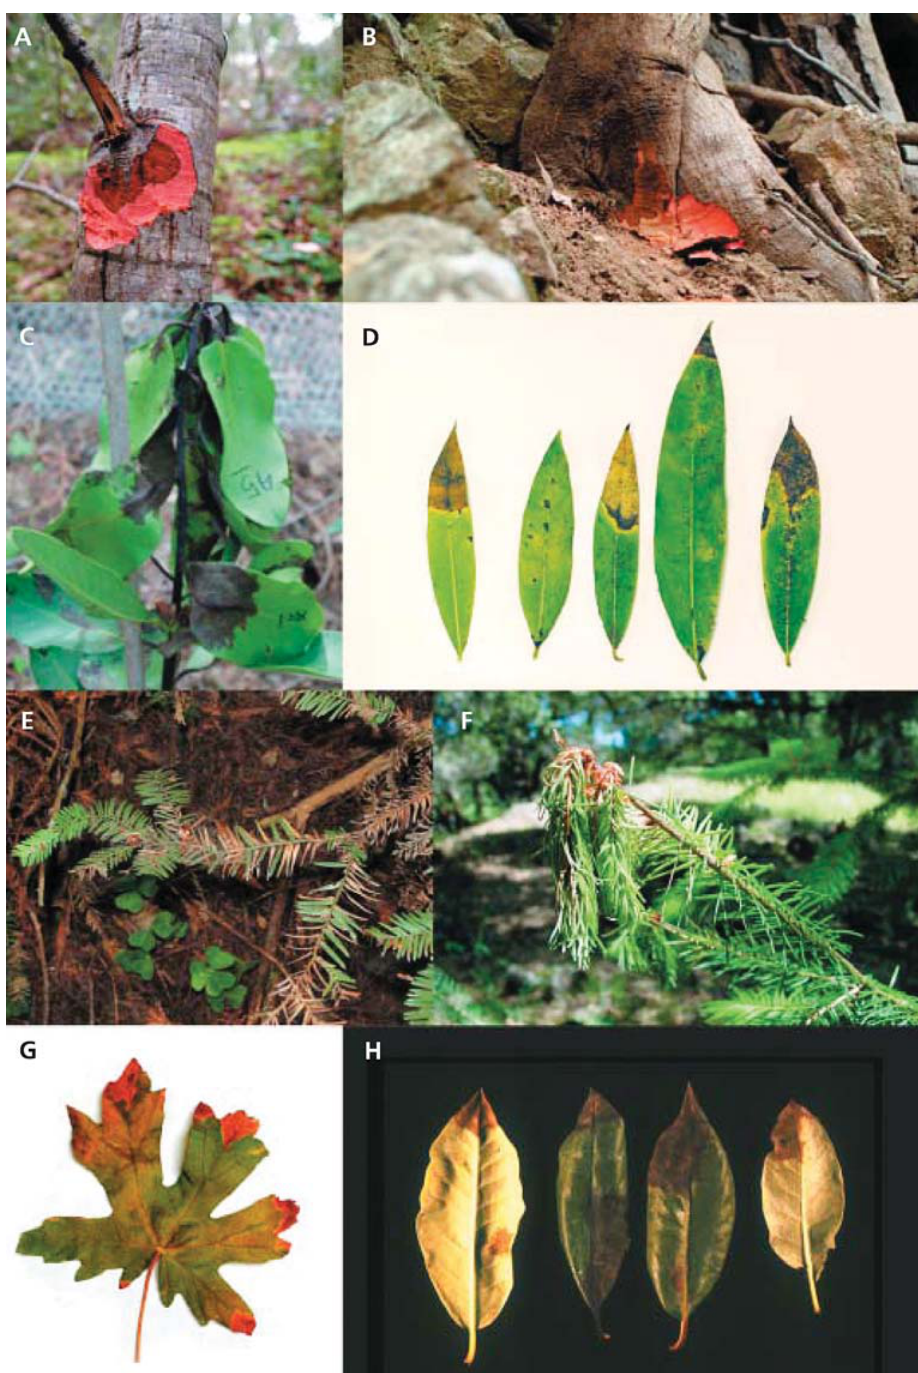
Fig. 3. Symptoms caused by Phytopthora ramorum on a range of hosts in California: A, aerial stem canker on tanoak; B, basal canker on tanoak ends at soil line; C, leaf blight and twig canker on Pacific Madrone seedlings; D, necrotic lesions on bay laurel leaves; E, needle blight on redwood; F, apical wilting on Douglas-fir; G, scorch on big leaf maple; H, leaf blight on rhododendron leave. (Printed from California Agriculture 57(1), 18–23, 2003, by per- mission of the Regents of the University of California, CA,